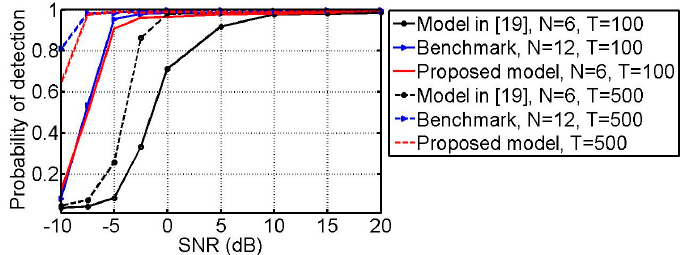
Figure 8. Probability of detection versus SNR with T = 100 and T = 500.